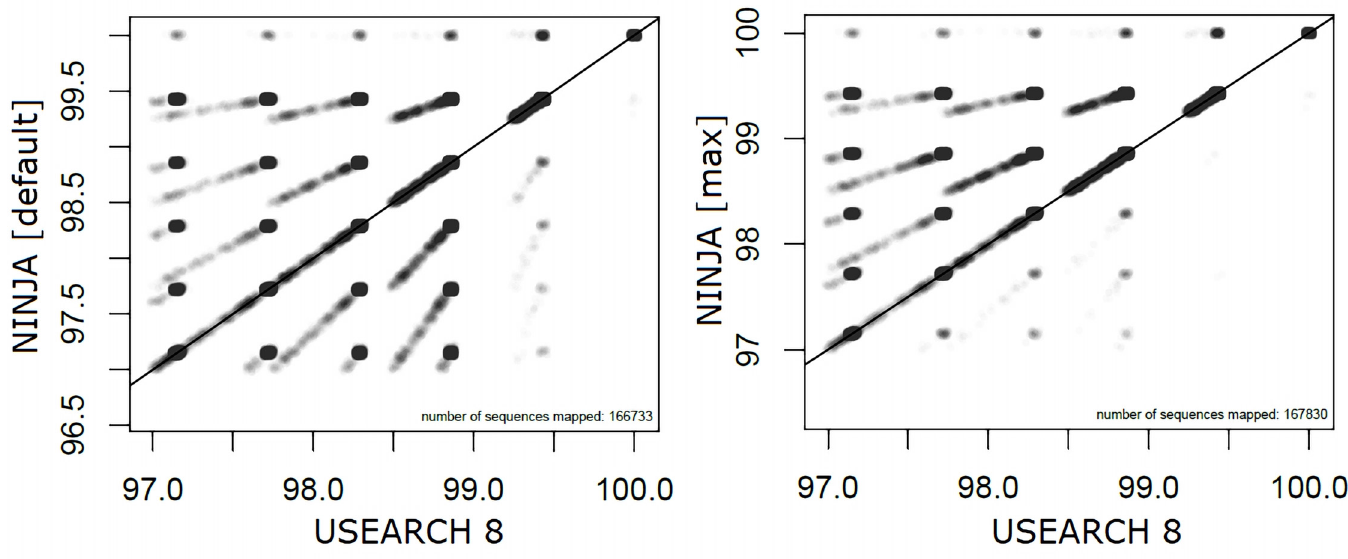
Fig 4. Alignment accuracy of NINJA vs USEARCH 8 (where both reported a match). Each point on the graph represents a sequence for which both tools found a valid alignment. A point ’ s position along the X axis corresponds to alignment score (in %ID) for the match chosen by USEARCH 8, and its position on the Y axis corresponds to the alignment score against the match chosen by NINJA. Points along the diagonal represent sequences for which both tools picked the same quality match. Points above the diagonal correspond to sequences for which NINJA produced more accurate hits, and points below the diagonal represent sequences for which USEARCH 8 produced more accurate hits. Note the presence of a line at the top of the graph showing a number of sequences for which NINJA selected a perfect match from the database while USEARCH 8 could